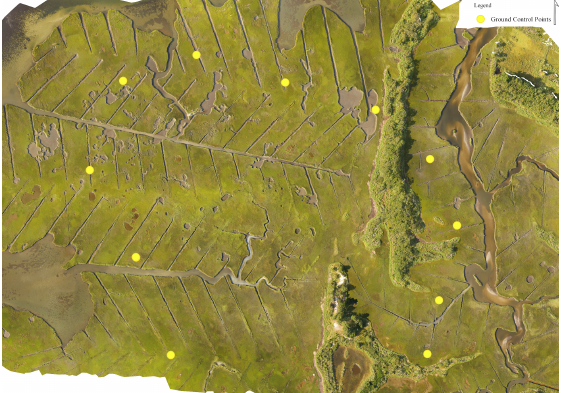
Figure 4. Differentially Corrected Ground Control Points Each ground control point was measured with at least 100 epochs, at a rate of 1 epoch per second. For the 11 GCPs a total of 1334 epochs were measured and then corrected in GPS Pathfinder Office. Corrections were made relative to the Operating Reference Station (CORS). 86.73% of the points were measured with a spatial resolution of 0.3 m - 0.5 m.